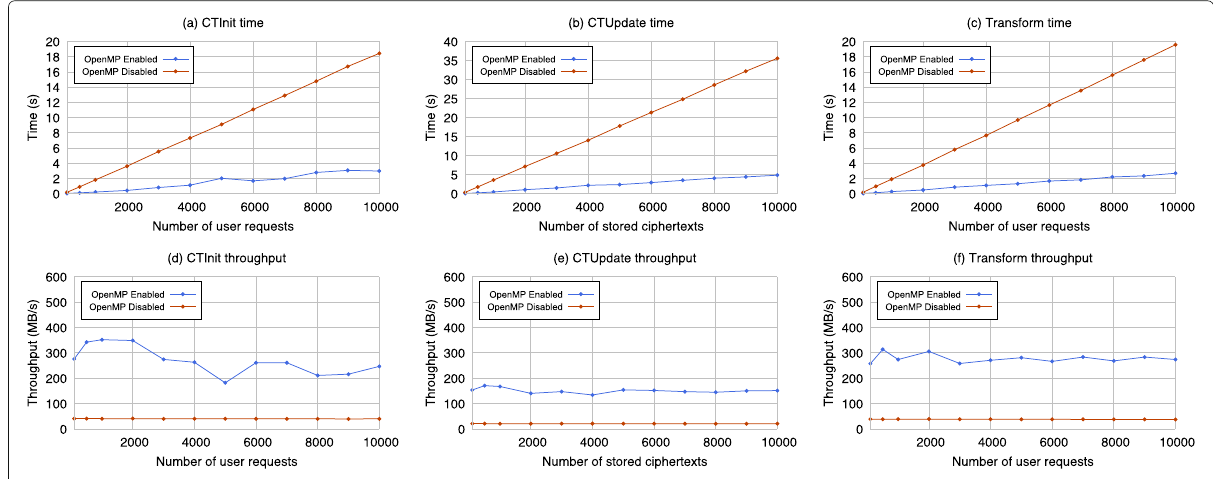
Fig. 4 Performance evaluation of the